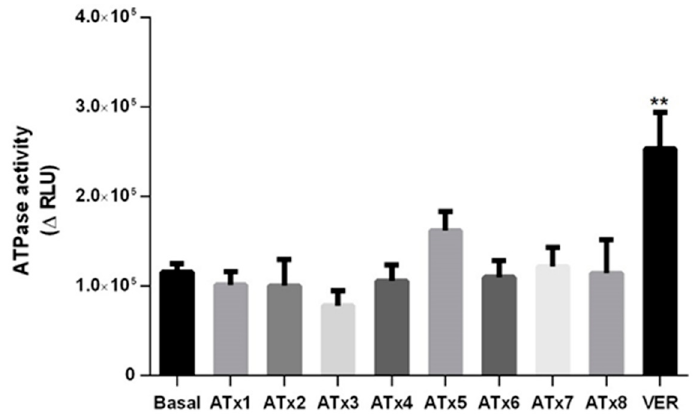
Figure 7. P-gp ATPase activity in the presence of chiral ATxs 1 – 8 . Results are expressed as mean ± SEM from three independent experiments (performed in triplicate). Statistical comparisons were estimated using One-way ANOVA, followed by Tukey’s multiple comparisons test (** p < 0.01 vs. basal P-gp ATPase activity).